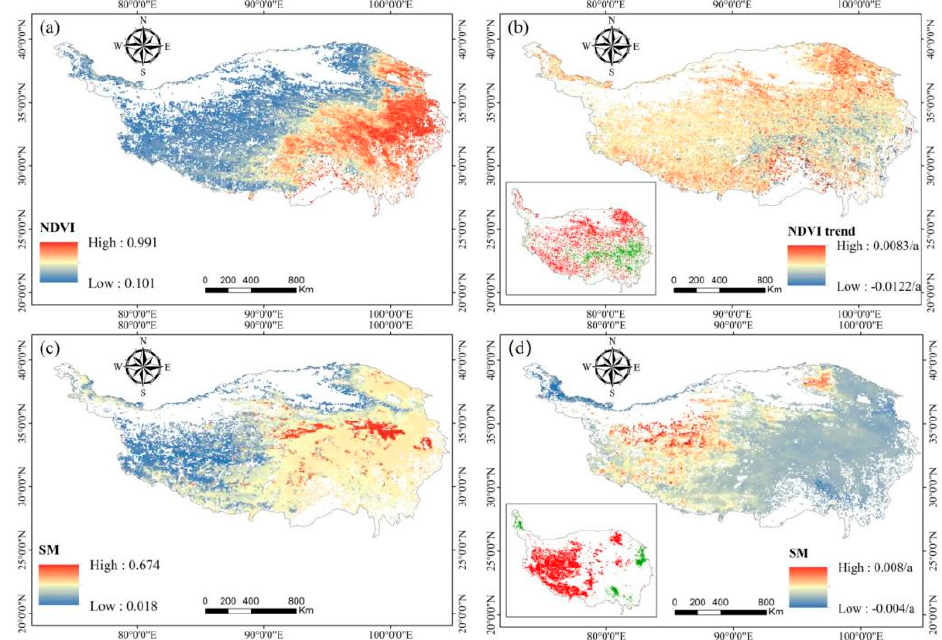
Figure 2. Spatial distribution and trends of NDVI and SM in grasslands on the TP from 1982 to 2015. ( a , c ) spatial distribution of annual grassland NDVI and SM, respectively. ( b , d ) spatial distribution of trends of annual grassland NDVI and SM, respectively; the illustration in the bottom left corner shows the significance ( p < 0.05) of the change in trend.